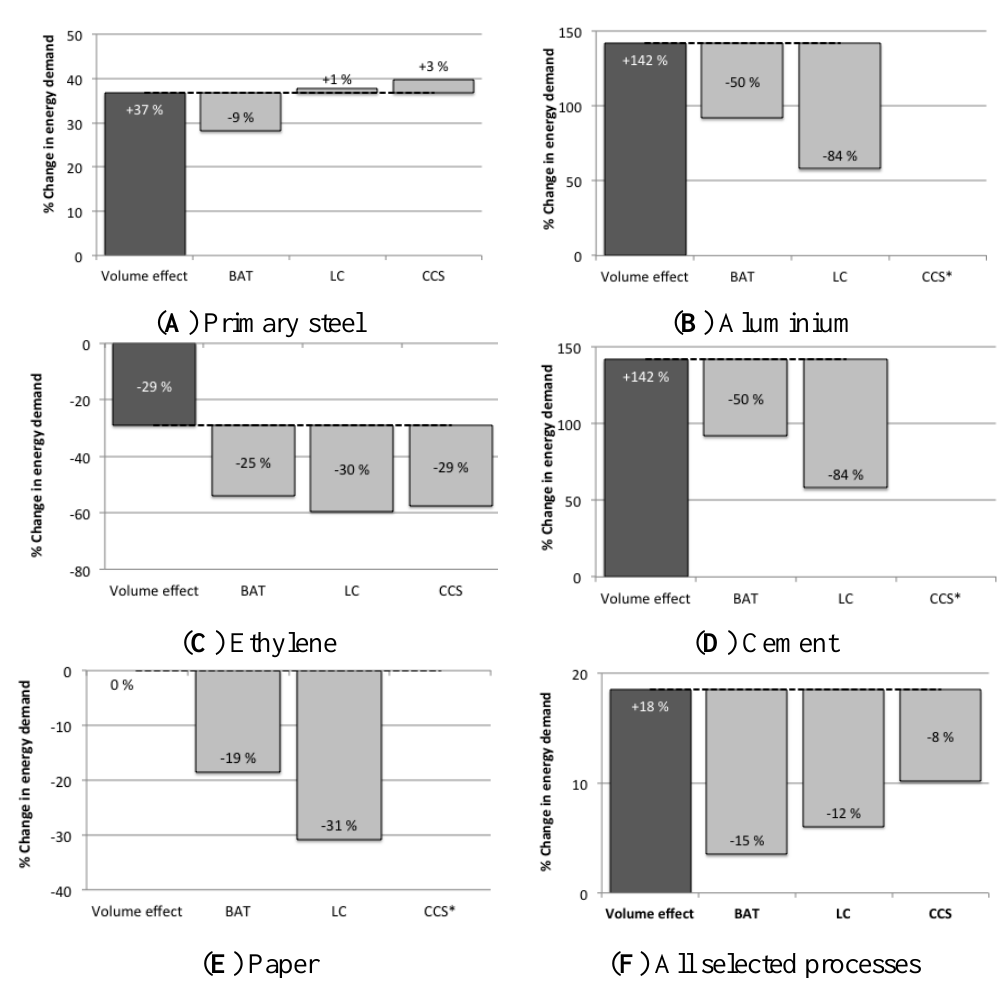
Figure 4. Percentage change in energy demand in 2050 in the three scenarios compared to 2010 levels in selected industrial production processes (panels A to E ) and overall for NRW ( F